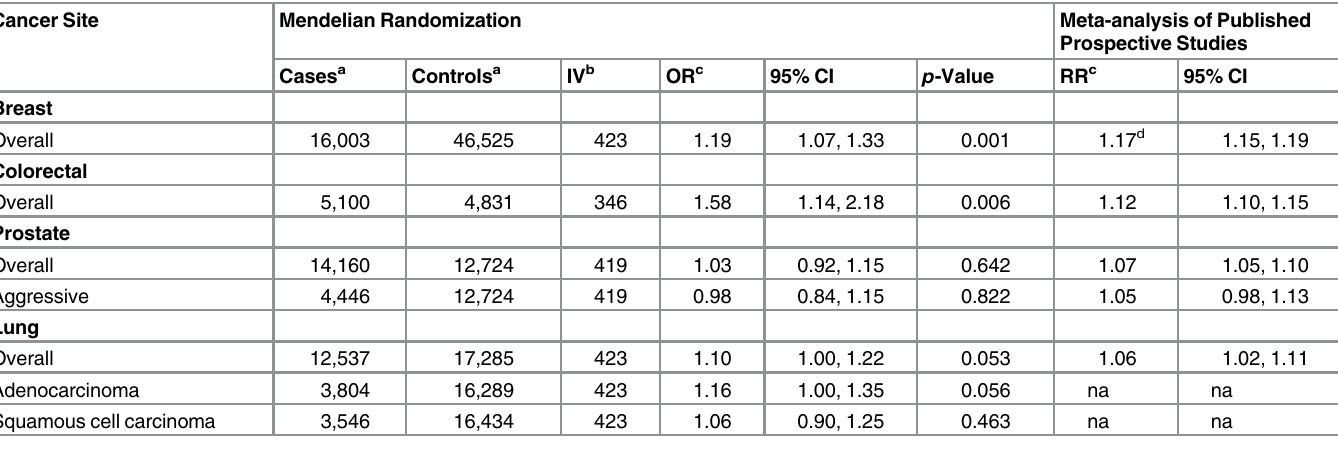
Table 1. Odds ratios and 95% confidence intervals estimated from Mendelian randomization analyses compared to the summary estimates (Figs 2 – 4) from published prospective studies for the association between adult height and cancers of the breast, colorectum, prostate, and lung.